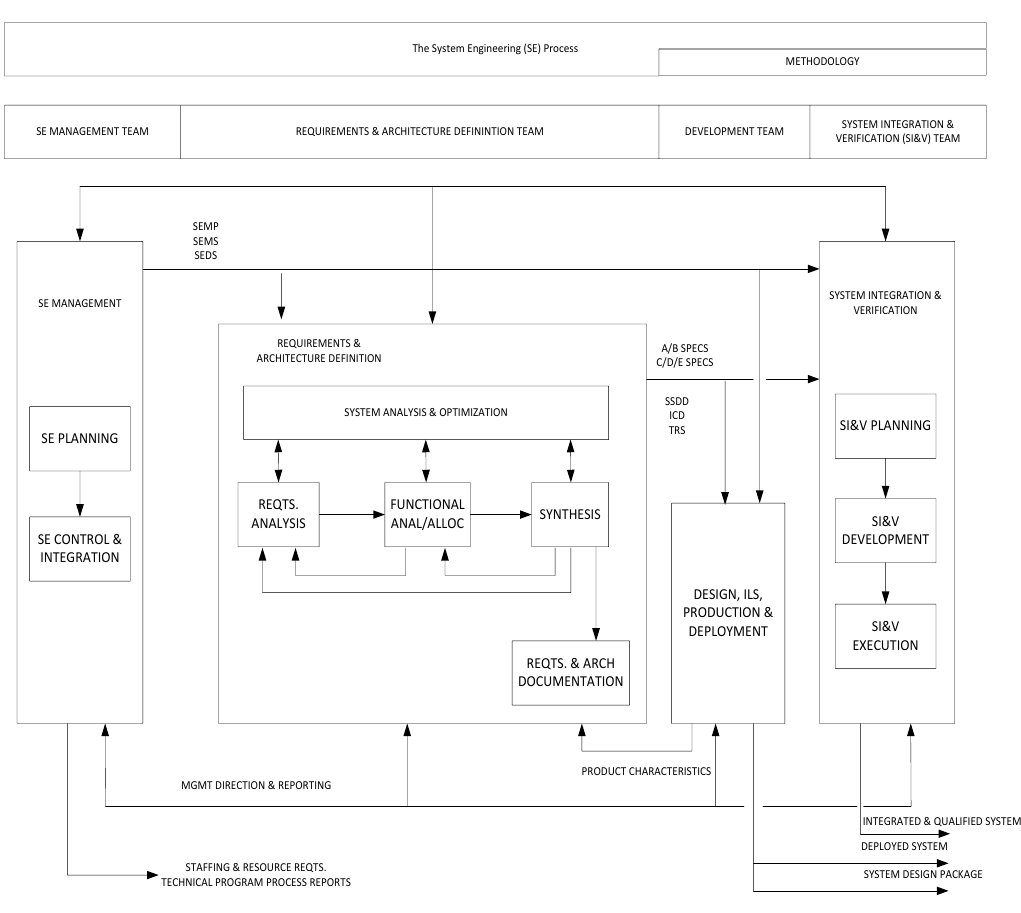
Fig. 3. System-based new product and/or strategy development approach (Martin,